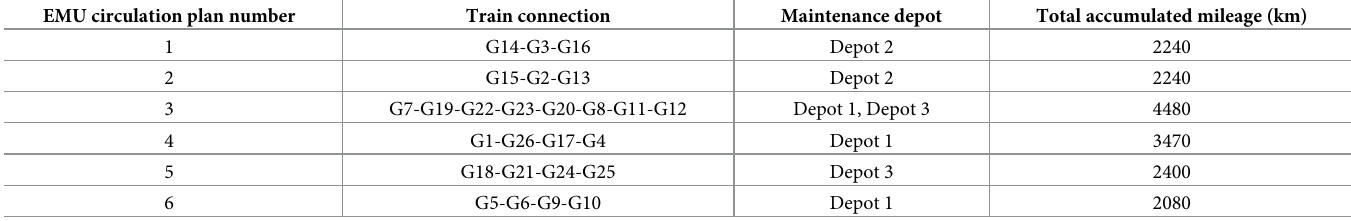
Table 9. EMU circulation plans in the collaborative